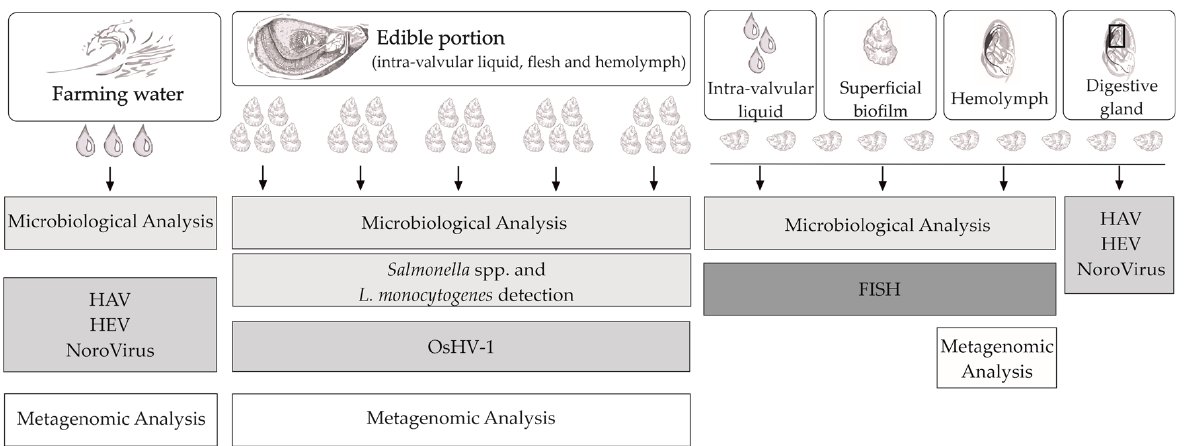
Figure 2. Experimental diagram. OsHV-1: oyster herpes virus; HAV: hepatitis A virus; HEV: hepatitis E virus; FISH: fluorescence in situ hybridization.